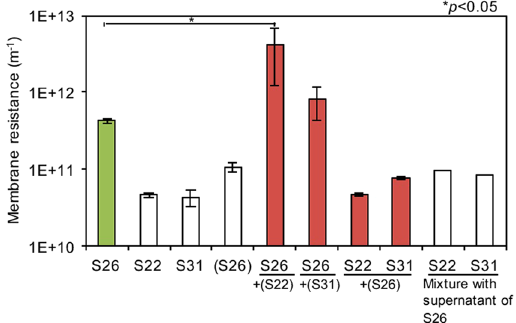
Figure 3. Effect of addition of the supernatants on fouling potential. The filter-sterilized supernatant of bacterial culture was added to M9 medium for cultivation of other strains. For example, S26 + (S22) indicates that S26 was cultured in the M9 medium with the filter-sterilized supernatant of S22 culture. The mixture of supernatants was also tested for fouling potential to assess abiotic effects by co-cultivating. The error bars indicate the standard deviations of two replicates except for the mixture of supernatants. The bar following sign indicates statistical difference between two groups with respective p value: * P <